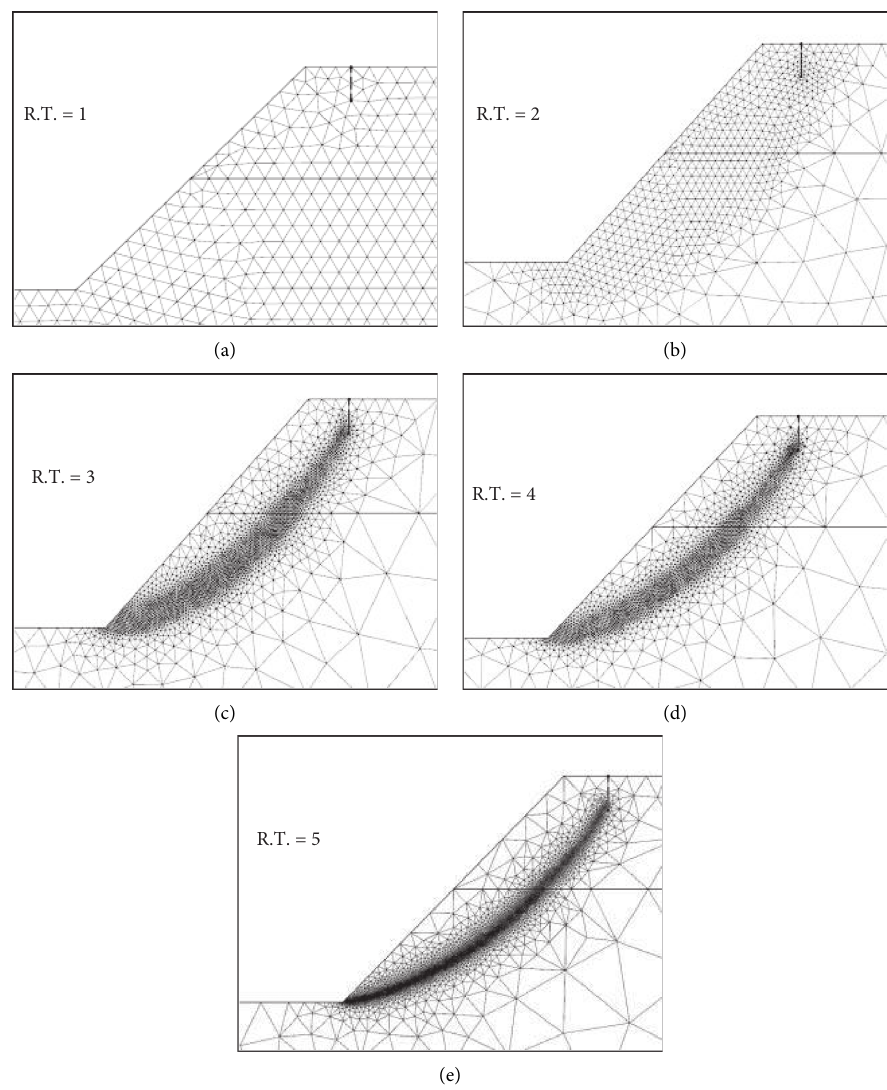
Figure 2: Meshing results of slope. (a) R.T. � 1. (b) R.T. � 2. (c) R.T. � 3. (d) R.T. � 4. (e) R.T. �